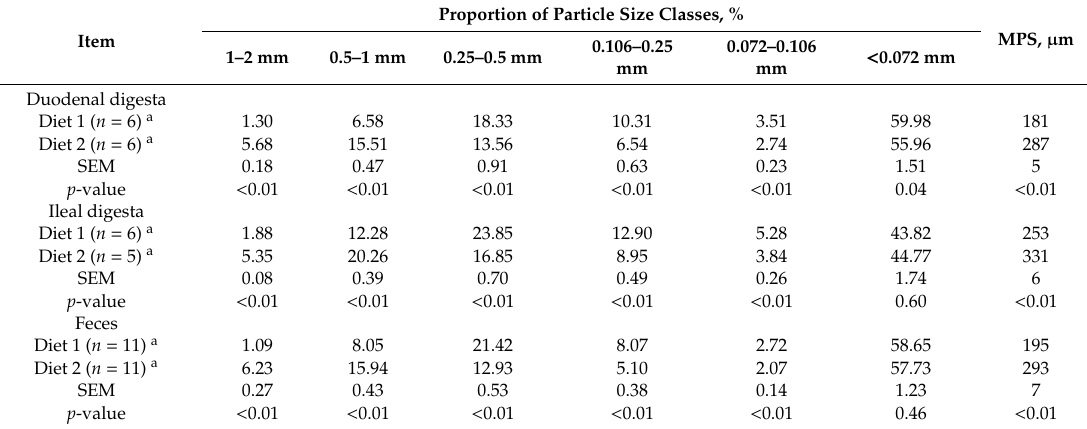
Table 3. E ff ect of dietary particle size on the proportion of particle size classes in the digesta and